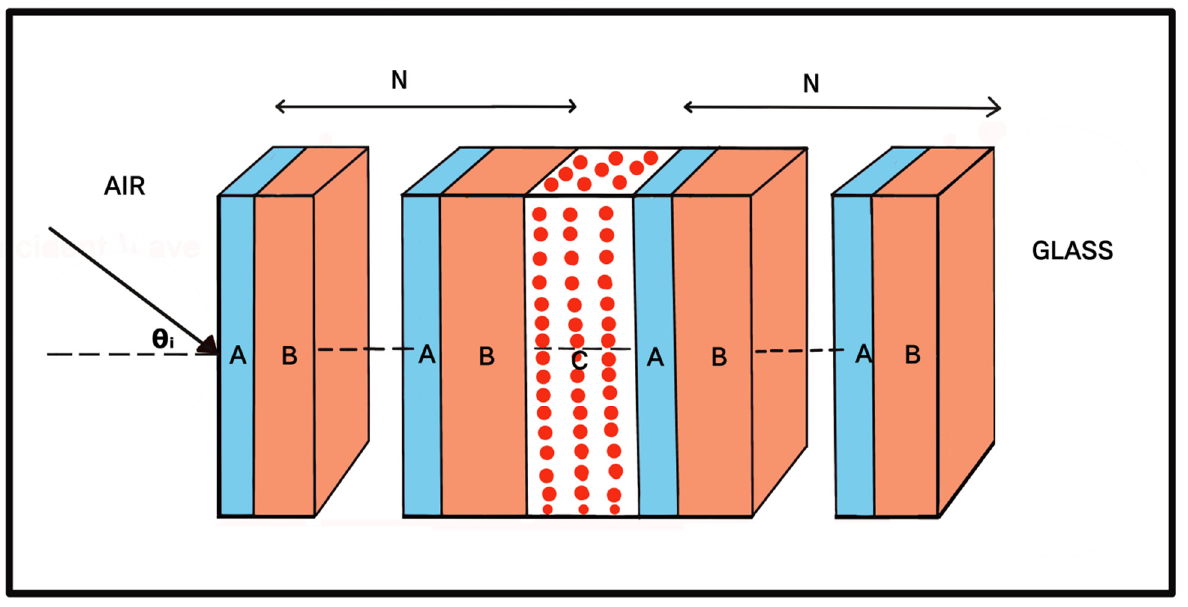
Figure 1. Schematic view of the proposed blood sensor for malaria detection and sensing composed of 1D photonic crystal with single defect.